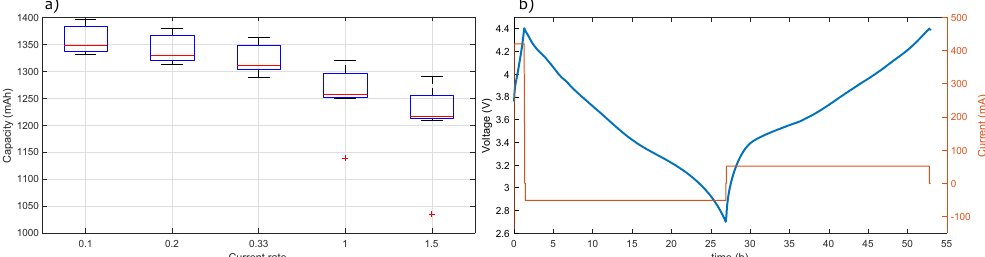
Figure 1. ( a ) Statistical analysis on the discharge capacity of Silicon cells at Beginning of Life (BoL) and ( b ) quasi-open circuit voltage test performed at BoL on a silicon cell.